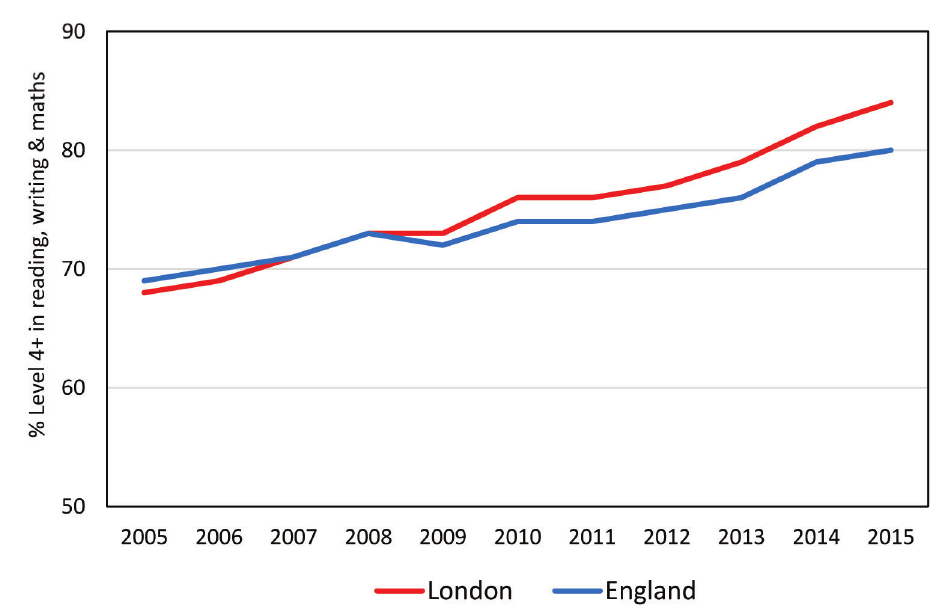
Figure 1: Key Stage 2, percentage Level 4+ in reading, writing and mathematics combined, 2005–15: London and national (DfE statistical first releases (SFRs), 2005 to